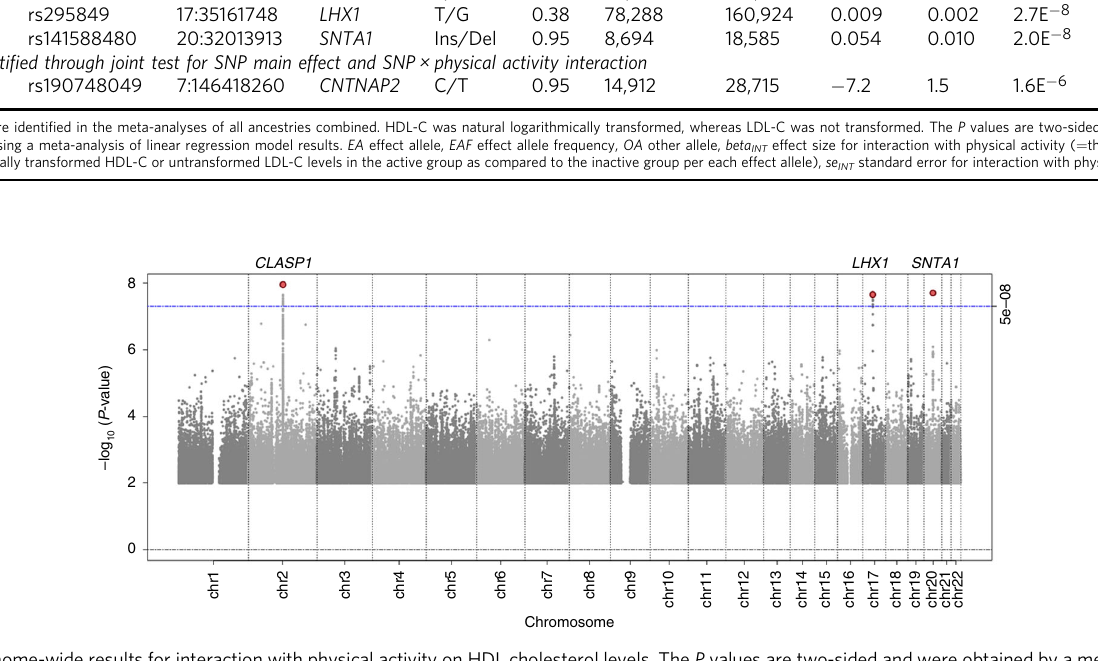
Fig. 1 Genome-wide results for interaction with physical activity on HDL cholesterol levels. The P values are two-sided and were obtained by a meta-analysis of linear regression model results ( n up to 250,564). Three loci, in/near CLASP1 , LHX1 , and SNTA1 , reached genome-wide signi fi cance ( P < 5 × 10 − 8 ) as indicated in the plot